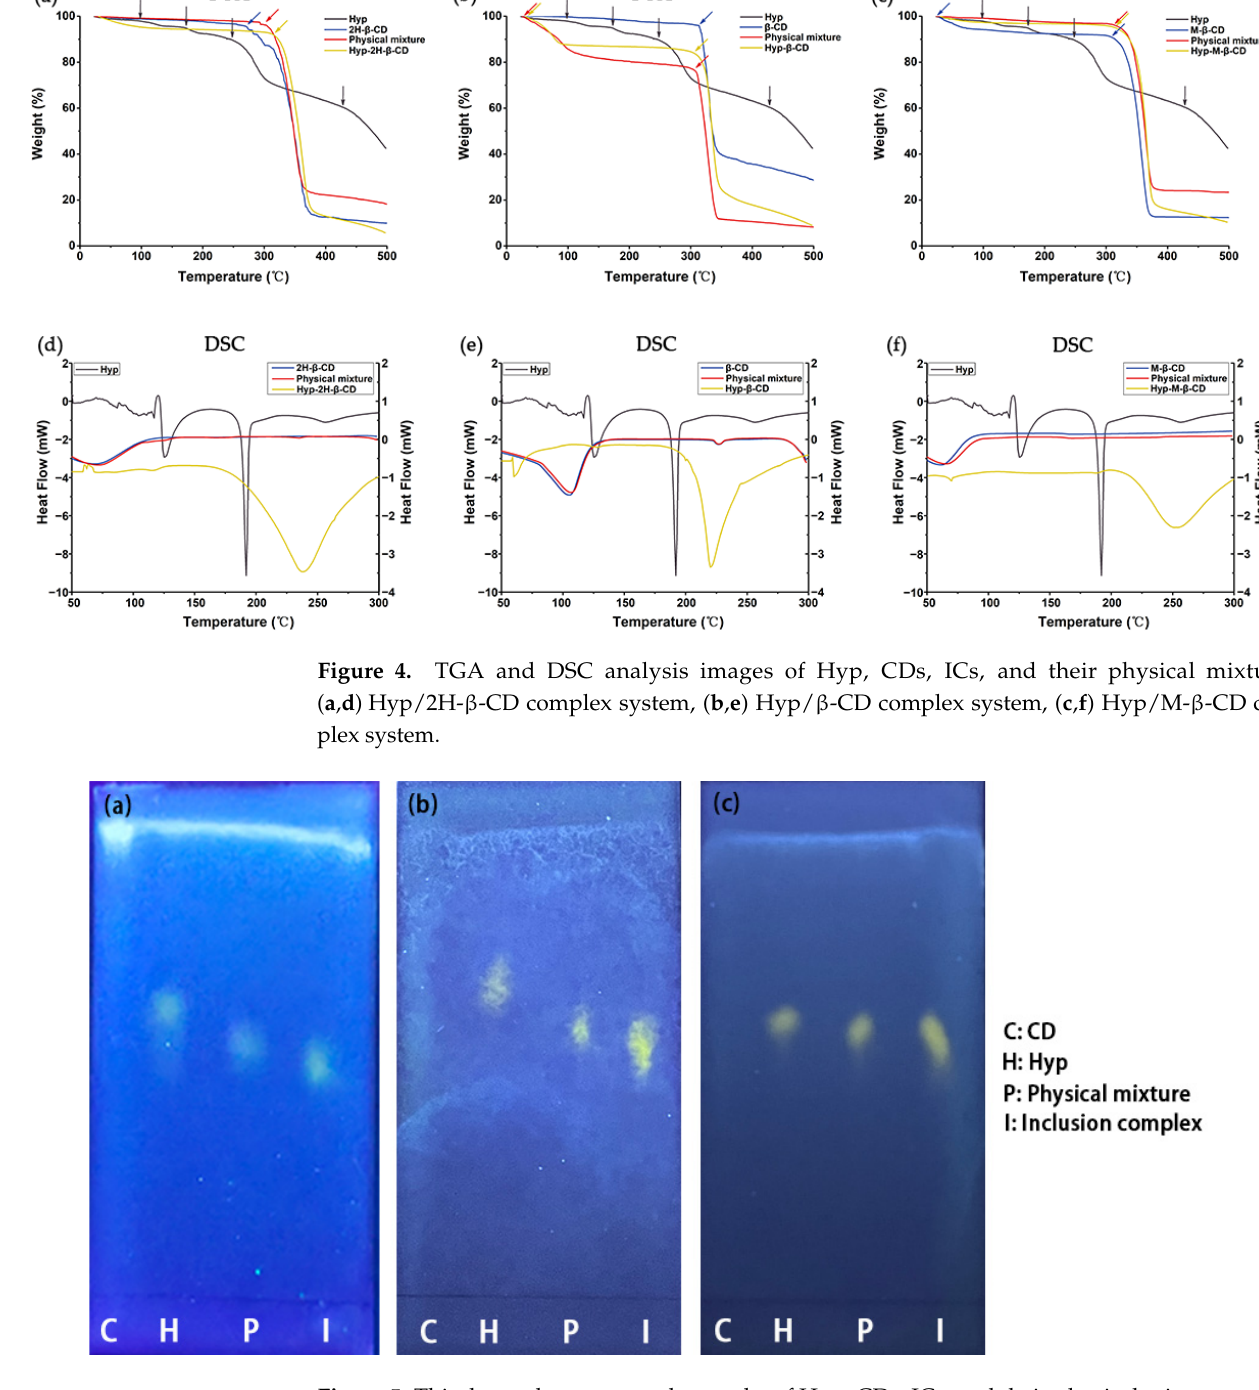
Figure 5. Thin-layer chromatography results of Hyp, CDs, ICs, and their physical mixtures under ultraviolet light. ( a ) Hyp/2H- β -CD complex system, ( b ) Hyp/ β -CD complex system, ( c ) Hyp/M- β - CD complex system.